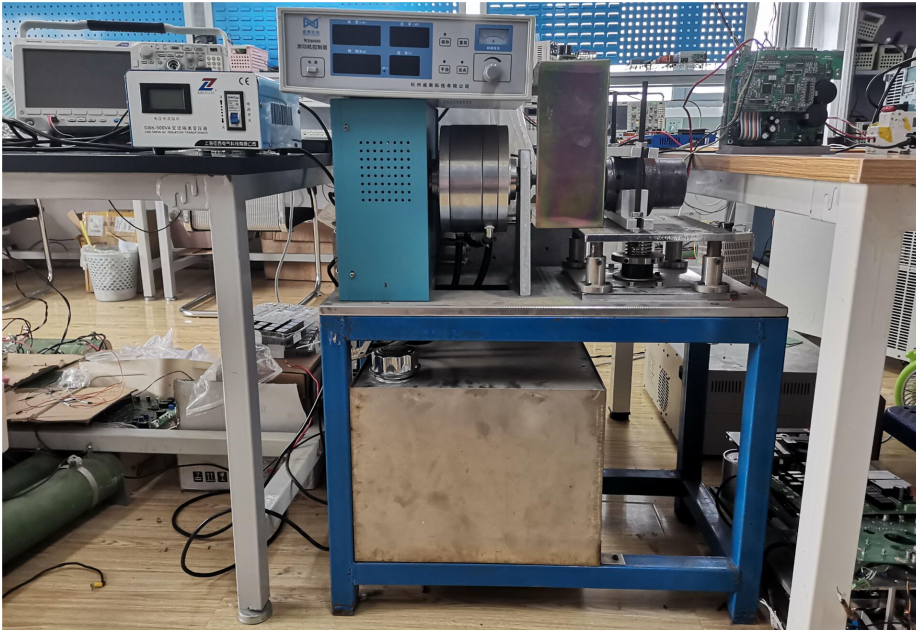
Figure 17. Test Bench of Prototype. The comparison of the motor performance between simulation and measurement are shown in Figures 18–20.